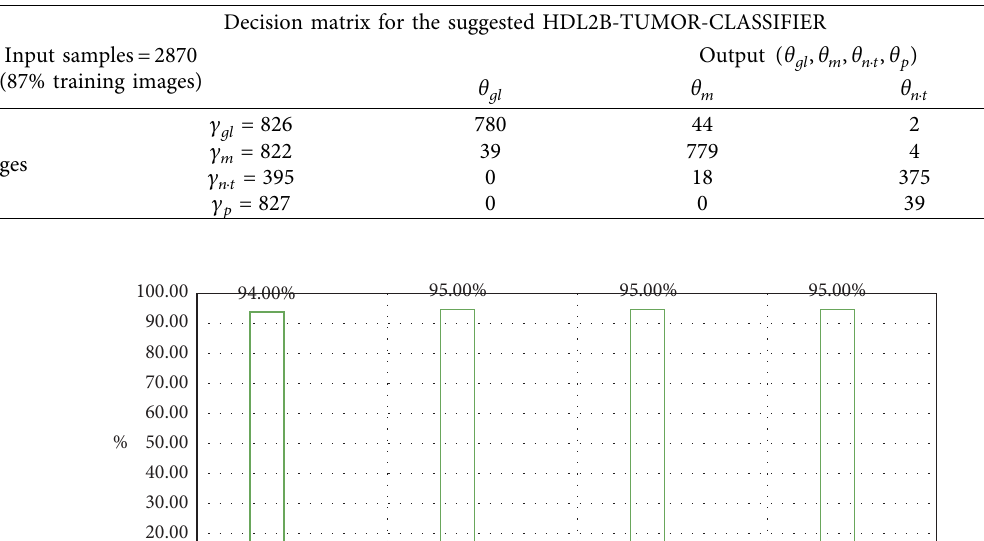
Table 2: Decision matrix for the suggested HDL2B-TUMOR-CLASSIFIER.